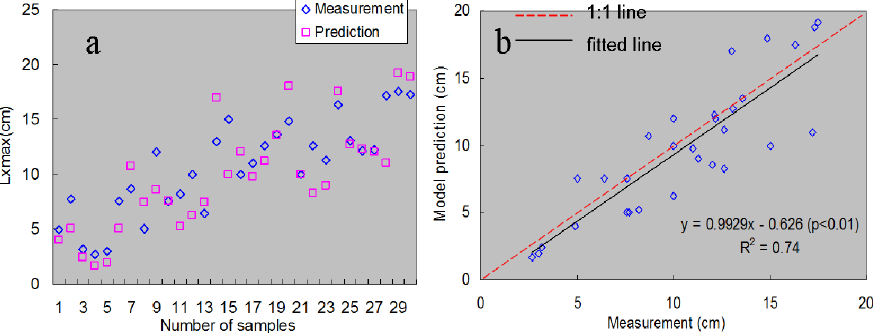
Figure 10. Model performance: ( a ) measurement versus prediction of the model ( n = 29); ( b ) linear relationship between model and measurement (RMSE = 4.8) ( n = 29).